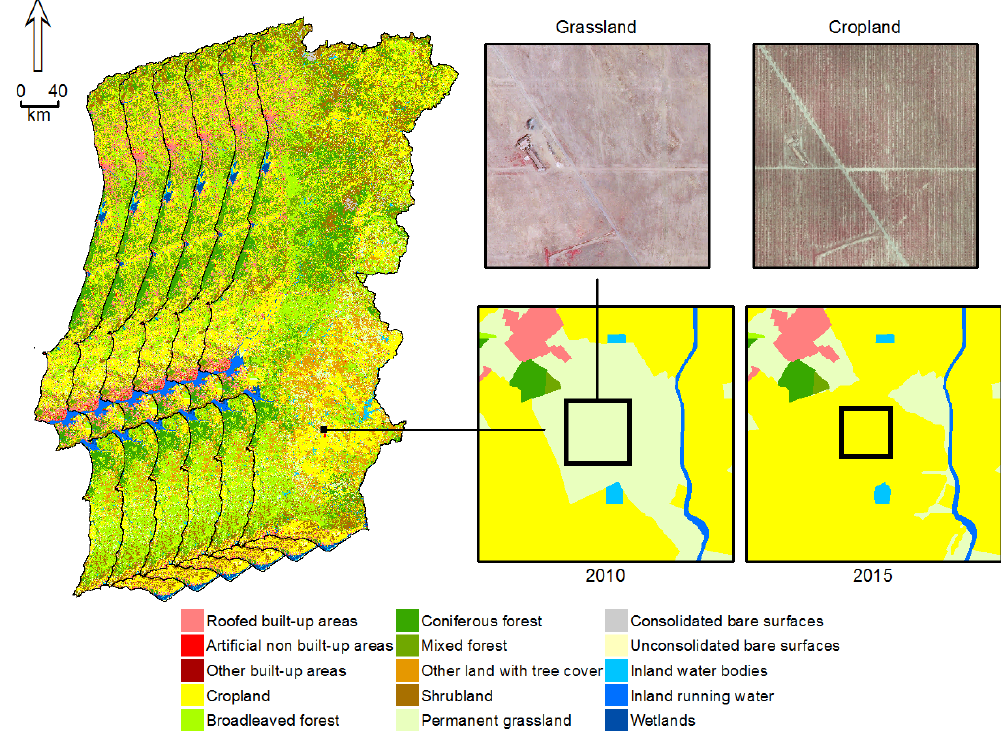
Figure 3. Land cover maps and an example of land cover change (grassland to cropland). Table 7. Mapped area (km 2 ) that changed as compared to the precedent year’s map (percentage of the country in brackets).